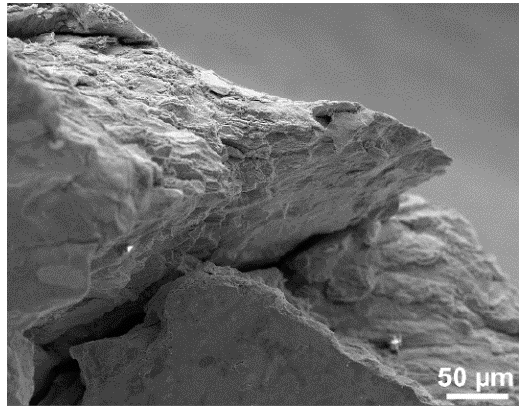
Figure 9. SEM-SE image of detail of cracked swaged piece processed at 700 °C.